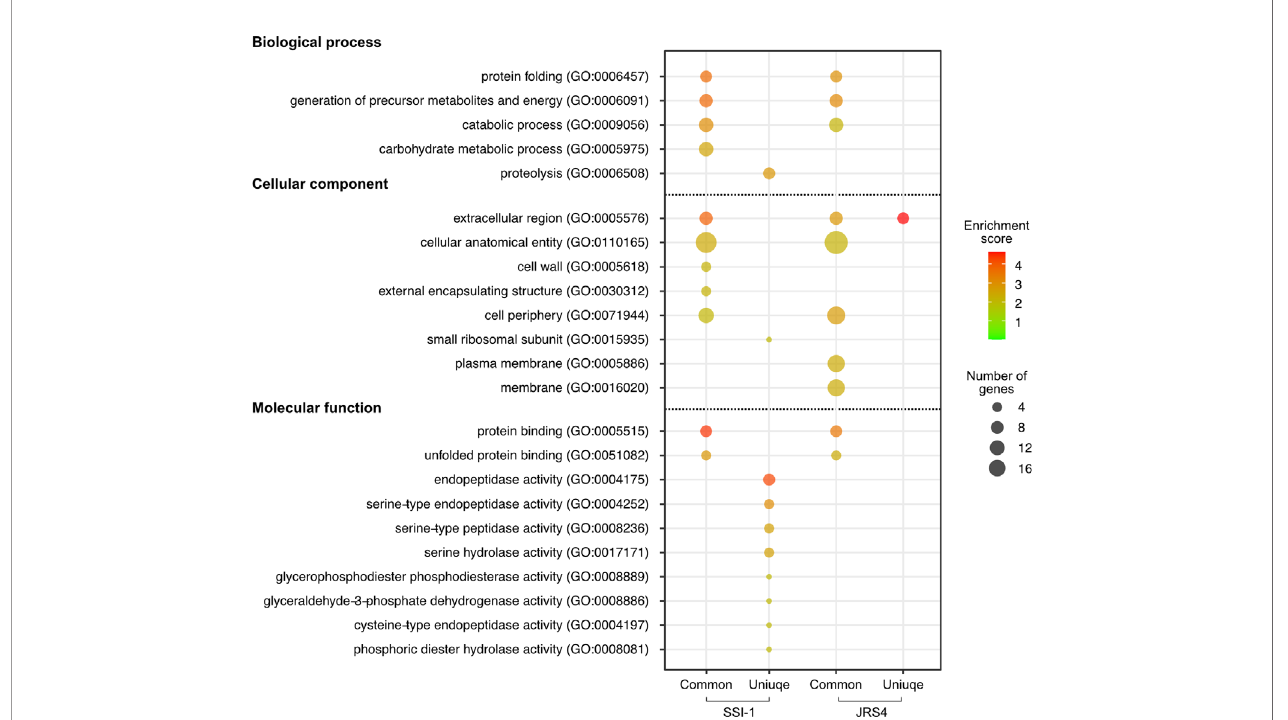
FIGURE 3 | GO enrichment analysis of proteins identi fi ed in EVs from SSI-1 and JRS4. GO enrichment analyses were performed with the whole SSI-1 and JRS4 proteins as references by using Fisher ’ s exact test with p-value. Enrichment scores are calculated by -log10-transformed p-value (P<0.01), and the scores and the number of genes corresponding to each GO term is represented by color key and circle size, respectively. Plot generation was implemented in R. The numbers shown in the parentheses indicate GO number corresponding to the GO